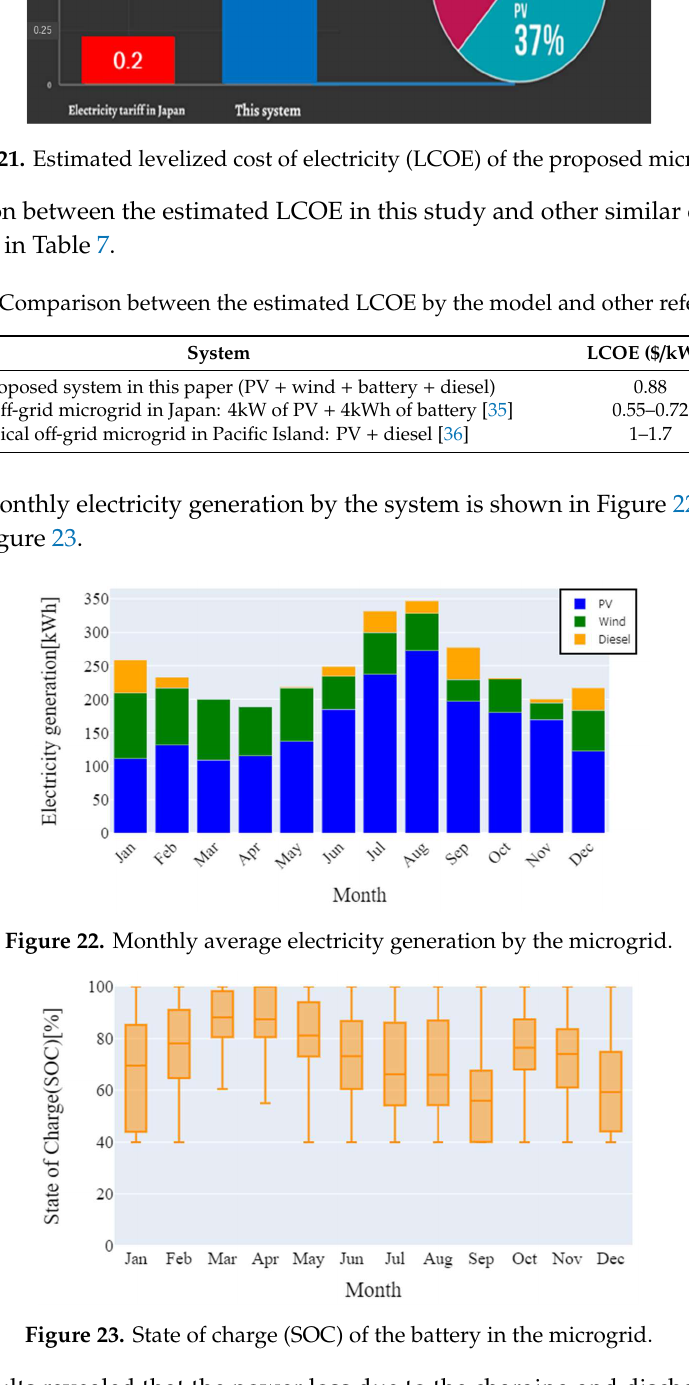
Figure 24. Annual energy balance in the proposed microgrid. 5.3. Assessing the Impact of Weather Conditions on the Optimal Performance and Power Dispatching of the Proposed System The microgrid’s fuel consumption and energy storage requirements are examined as a function of the atmospheric conditions. Weather data is thus necessary to establish optimal operating and